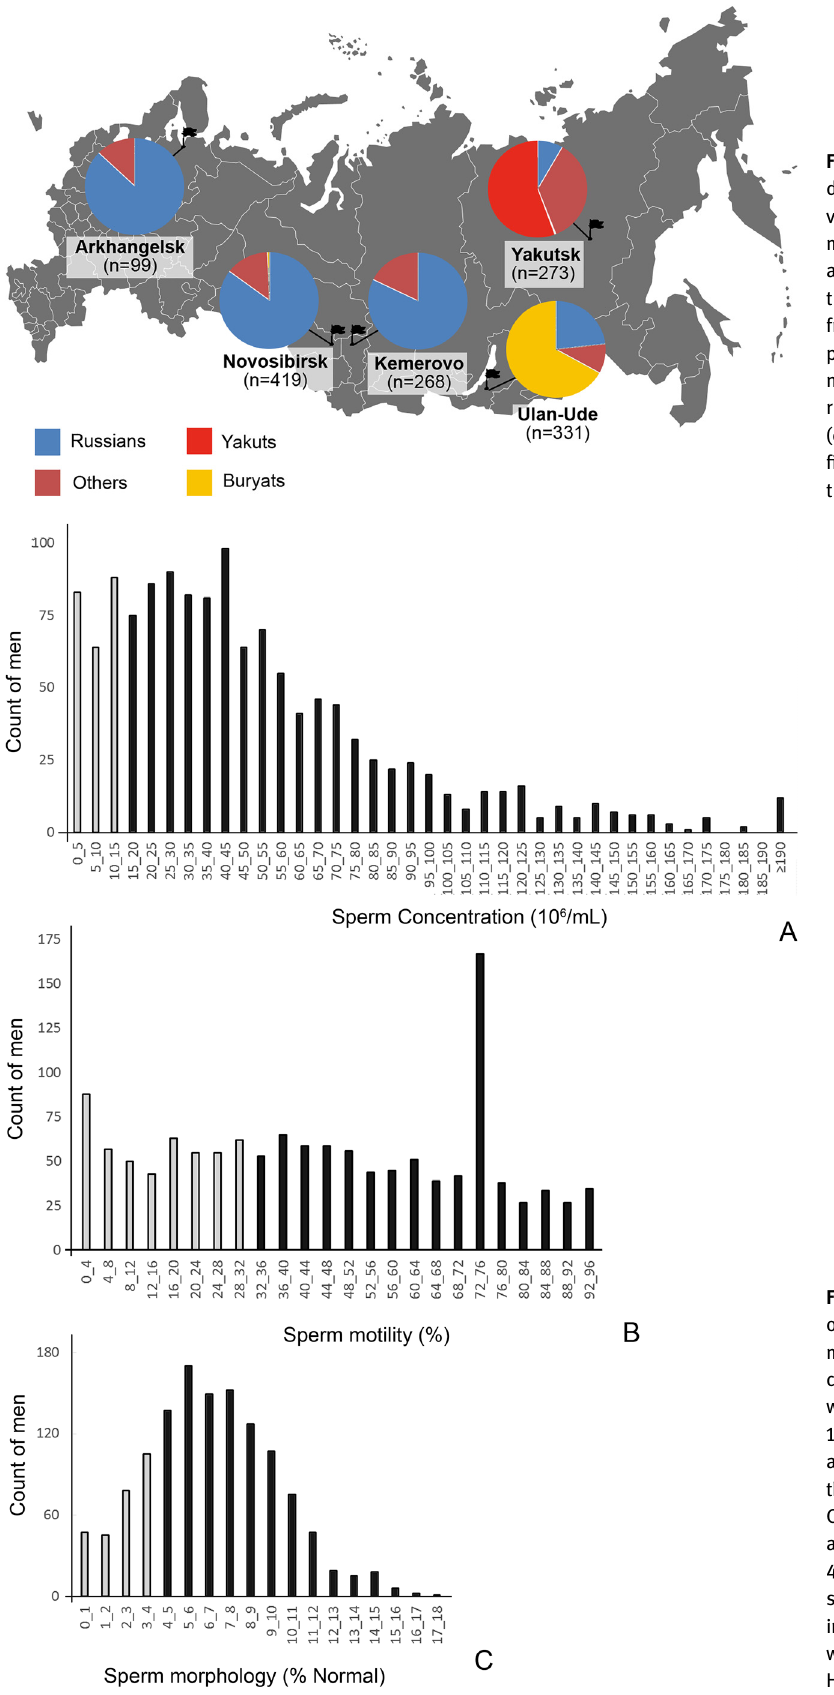
Figure 3: Frequency